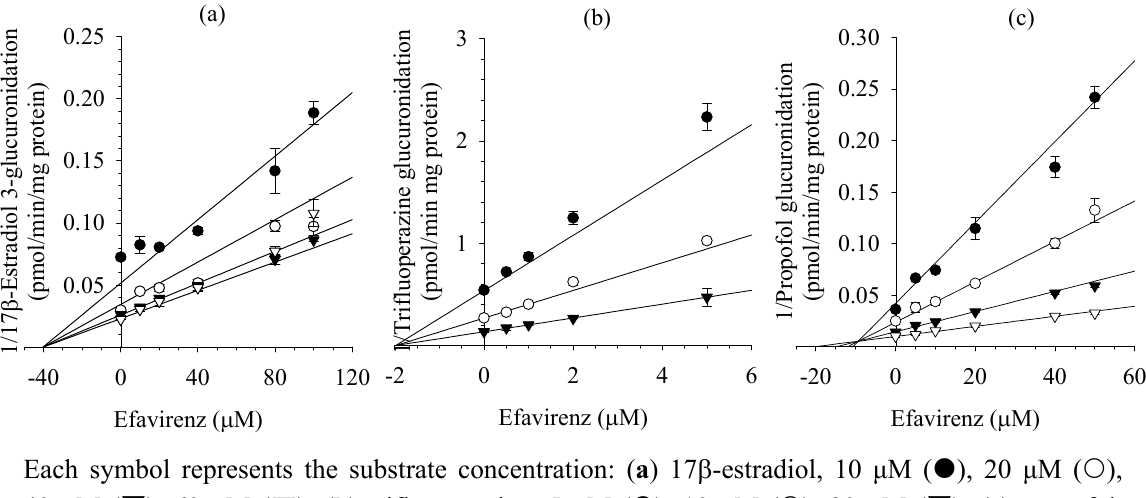
Each symbol represents the substrate concentration: ( a ) 17  -estradiol, 10 μ M (  ), 20 μ M (  ), 40 μ M (  ), 60 μ M ( ▽ ); ( b ) trifluoperazine, 5 μ M (  ), 10 μ M (  ), 20 μ M (  ); ( c ) propofol, 5 μ M (  ), 10 μ M (  ), 20 μ M (  ), 40 μ M ( ▽ ). Each data represents the mean and standard deviation of triplicate